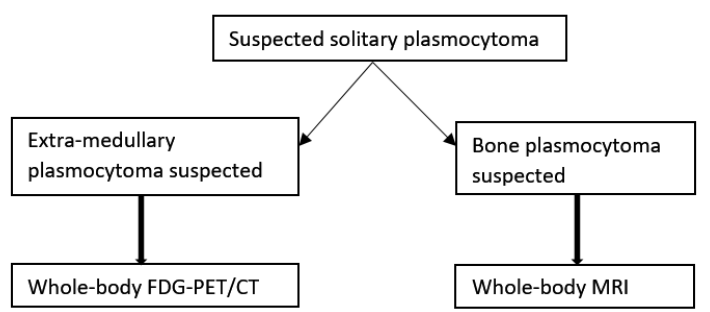
Figure 6. Imaging algorithm for patients with solitary plasmocytoma suspected. MRI: magnetic resonance imaging. Based on “Hillengass J, Usmani S, Rajkumar SV, Durie BGM, Mateos M-V, Lonial S, et al. International myeloma working group consensus recommendations on imaging in monoclonal plasma cell disorders. The Lancet Oncology. 2019” [28].